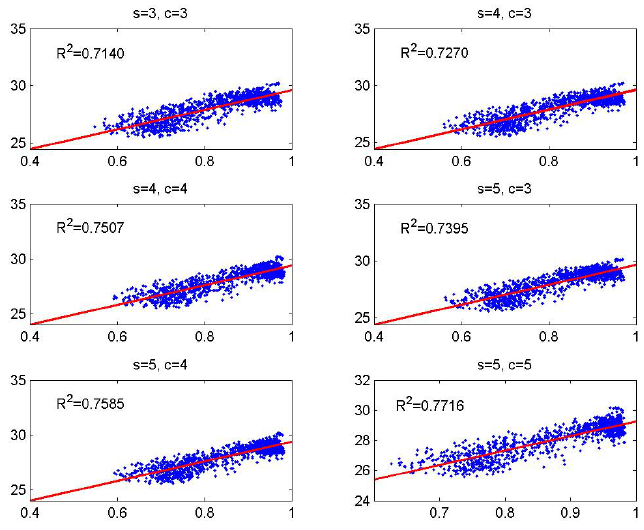
Fig. 5. Scatter plot of STC (x-axis) vs mean of SST time-slice (y- axis) for each set of s and c in Fig. 4.